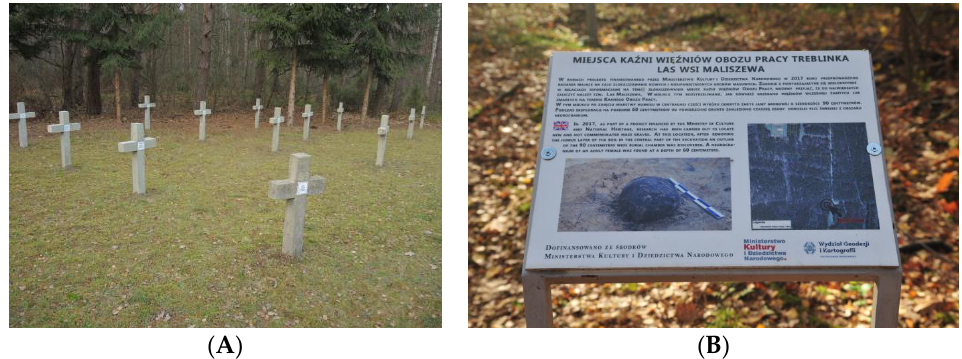
Figure 2. ( A ) Crosses on the execution site and mass graves; the so-called Maliszewa Forest (2016); photo: R. Zapłata. ( B ) Board with information about the research conducted by the authors in 2017, mounted at the site of the conducted archaeological survey; photo: S. Różycki.